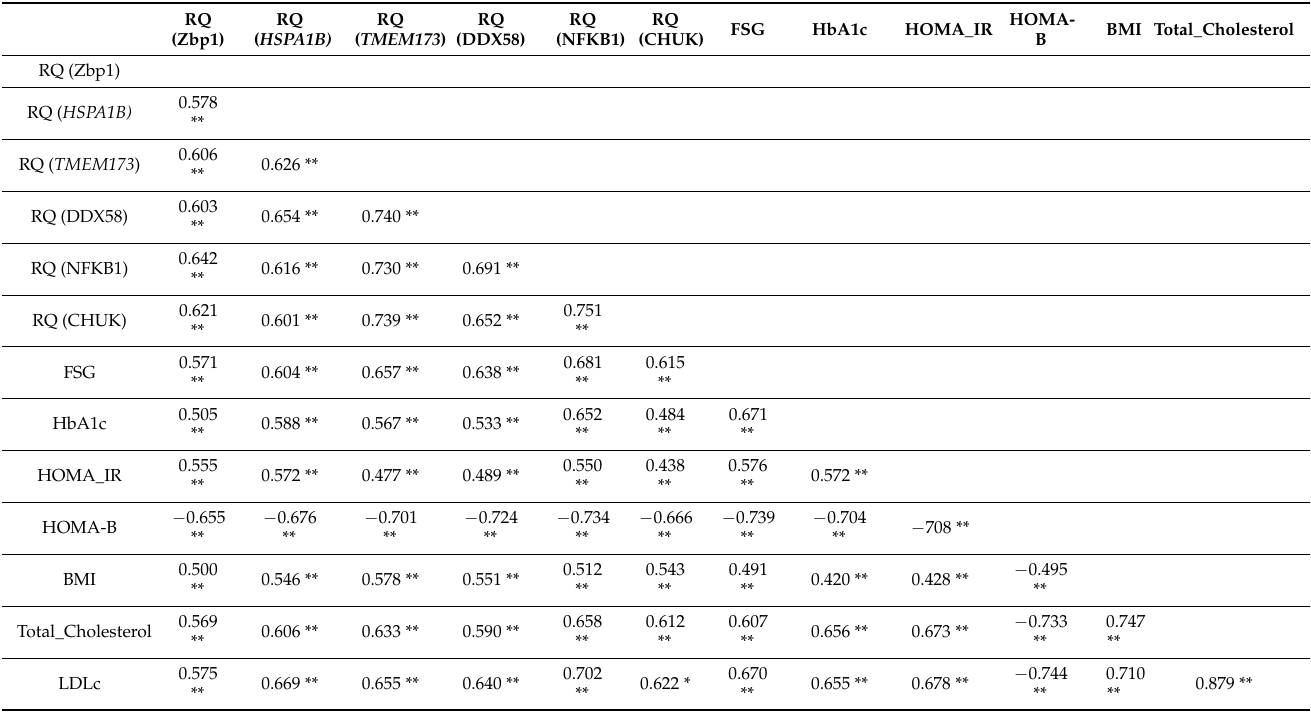
Table 5. Correlation between the 6 mRNAs and the different clinicopathological